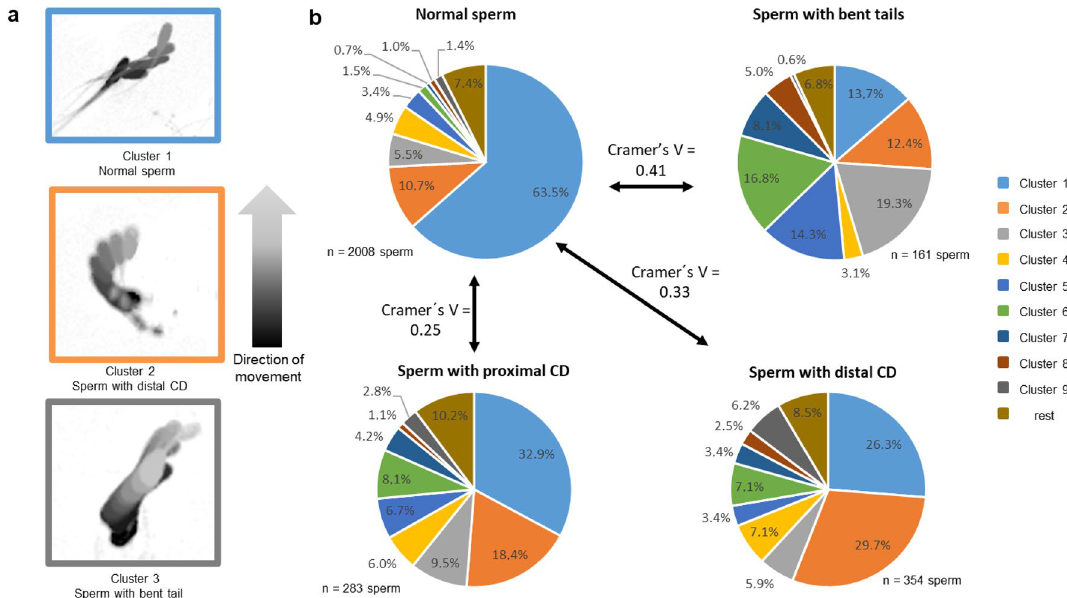
Figure 2. Representative sperm tracks in the three main clusters ( a ) and distribution of spermatozoa with cytoplasmic droplet (CD) or bent tail compared to sperm with normal tail morphology (normal sperm) in nine kinematic clusters ( b ). Data are based on sperm tracks analysed after a 30-min incubation period at 38 °C in Beltsville Thawing Solution from extended semen samples (n = 10 boars) with enhanced prevalence (≥ 15%) of cytoplasmic droplets or bent tails. Only clusters containing at least 5% of sperm in any of the sperm subsets were considered for evaluation. Cramer’s V (range from 0 to 1) indicates the effect size of a certain morphological defect on sperm distribution to the different cluster (movement patterns). V < 0.1 = no effect; 0.1 ≤ V < 0.3 small effect; 0.3 ≤ V < 0.5 moderate effect; V ≥ 0.5 = large sperm tracks (63%) were allocated to Cluster 1 with a high LIN, moderate values for VCL and moderate values for ALH. The sperm morphology had a significant impact on the distribution of the cells to the different motility patterns (Fig. 2b). The effect size was moderate for sperm with bent tails ( χ 2 (9; N = 2169) = 362.4, p < 0.0001, V = 0.41) and sperm with distal CD ( χ 2 (9; N = 2362) = 251.2, p < 0.0001, V = 0.33), but low for sperm with proxi- mal CD ( χ 2 (9; N = 2291) = 144.7, p < 0.0001, V = 0.25). The effect in all groups was mainly based on a lower num- ber of spermatozoa in Cluster 1 and a higher number of spermatozoa in Cluster 7, the latter being characterised by low values for VCL and LIN. Spermatozoa with distal CD showed a high frequency of cells (30%) in Cluster 2 represented by high values for VCL and ALH. Experiment 2. Sperm response to procaine. Experiment 2a): Impact of the presence of sperm with ab- normal tail morphology (CD, bent tail) on the movement patterns of sperm with normal tails after stimulation with procaine. Incubation for 10 min in presence of procaine resulted in a distinct change in the movement pattern in many spermatozoa with normal morphology. The effect of procaine was characterised by star-like motility tracks (Fig. 3) which indicated fast movement with low LIN and high ALH of lateral head-displacement (Fig. 4a, Cluster 5). The origin of the normal spermatozoa from either high or low MAS samples had a moderate effect size under control conditions ( χ 2 (7; N = 2283) = 287.4, p < 0.0001, V = 0.35). Nonetheless, exposure to procaine had a significant impact on the motility patterns of the spermatozoa (Figs. 4b and 5) with a strong effect size for normal sperm from both low MAS samples ( χ 2 (7; N = 2920) = 1146.1, p < 0.0001, V = 0.63) and high MAS sam- ples ( χ 2 (7; N = 2180) = 761.5, p < 0.0001, V = 0.59). In both cases, a significant increase in the average percentage of sperm from Cluster 5 was observed as the main change (Figs. 4b and 5e). Noteworthy, the effect of sperm origin was small after procaine stimulation (Fig. 4b). Experiment 2b): Impact of sperm tail morphology on movement patterns after stimulation with procaine. After centrifugation and incubation, the differences in the motility patterns between morphologically normal sperma- tozoa and sperm with proximal or distal CD, or bent tail were moderate to small (data not shown). The effect size of procaine stimulation was moderate for sperm with proximal CD ( χ 2 (7; N = 173) = 37.6, p < 0.0001, V = 0.47) and for sperm with bent tail ( χ 2 (7; N = 185) = 18.4, p < 0.01, V = 0.37; Fig. 6). For sperm with distal CD, the effect size was strong ( χ 2 (7; N = 358) = 124.1, p < 0.0001, V = 0.59) and the effect of the distal CD on the distribution of sperm to the different motility cluster was very small ( χ 2 (7; N = 1825) = 37.7, p < 0.0001, V = 0.14) when com- pared to morphologically normal sperm.